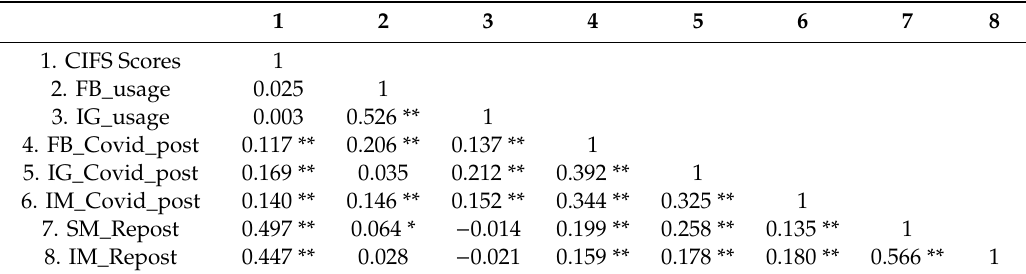
Table 3. Summary of correlation for CIFS scores and social media